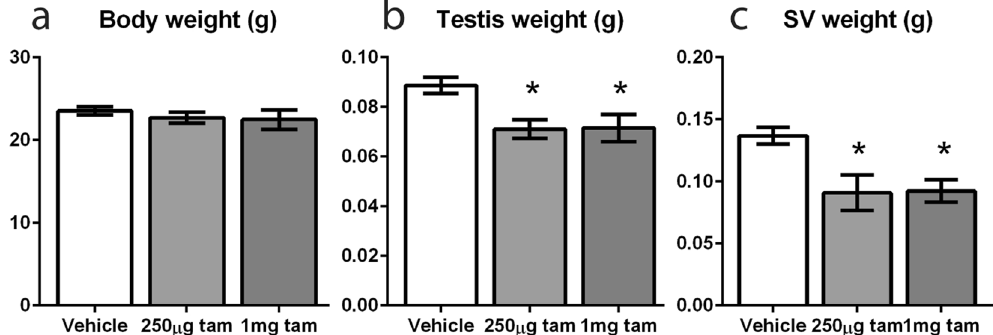
Figure 4. A single dose of 1 mg or 250 µ g tamoxifen at d16 does not delay testis descent, yet still reduces testis weight. ( a ) INYF mice treated with either 1 mg or 250 µ g tamoxifen at d16 do not have a significant change in body weight compared to controls at 7 weeks. ( b ) Both 1 mg and 250 µ g groups have a significant reduction in testis weight compared to controls at 7 weeks. ( c ) Both 1 mg and 250 µ g groups have a significant reduction in SV weight compared to controls at 7 weeks. (All measurements n ≥ 6, error bars are